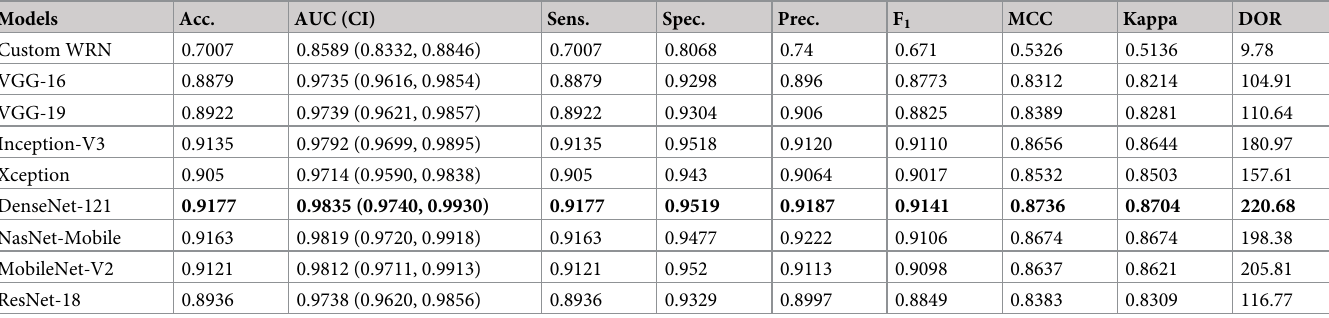
Bold numerical values denote best performances in the respective columns. None of these individual differences are statistically